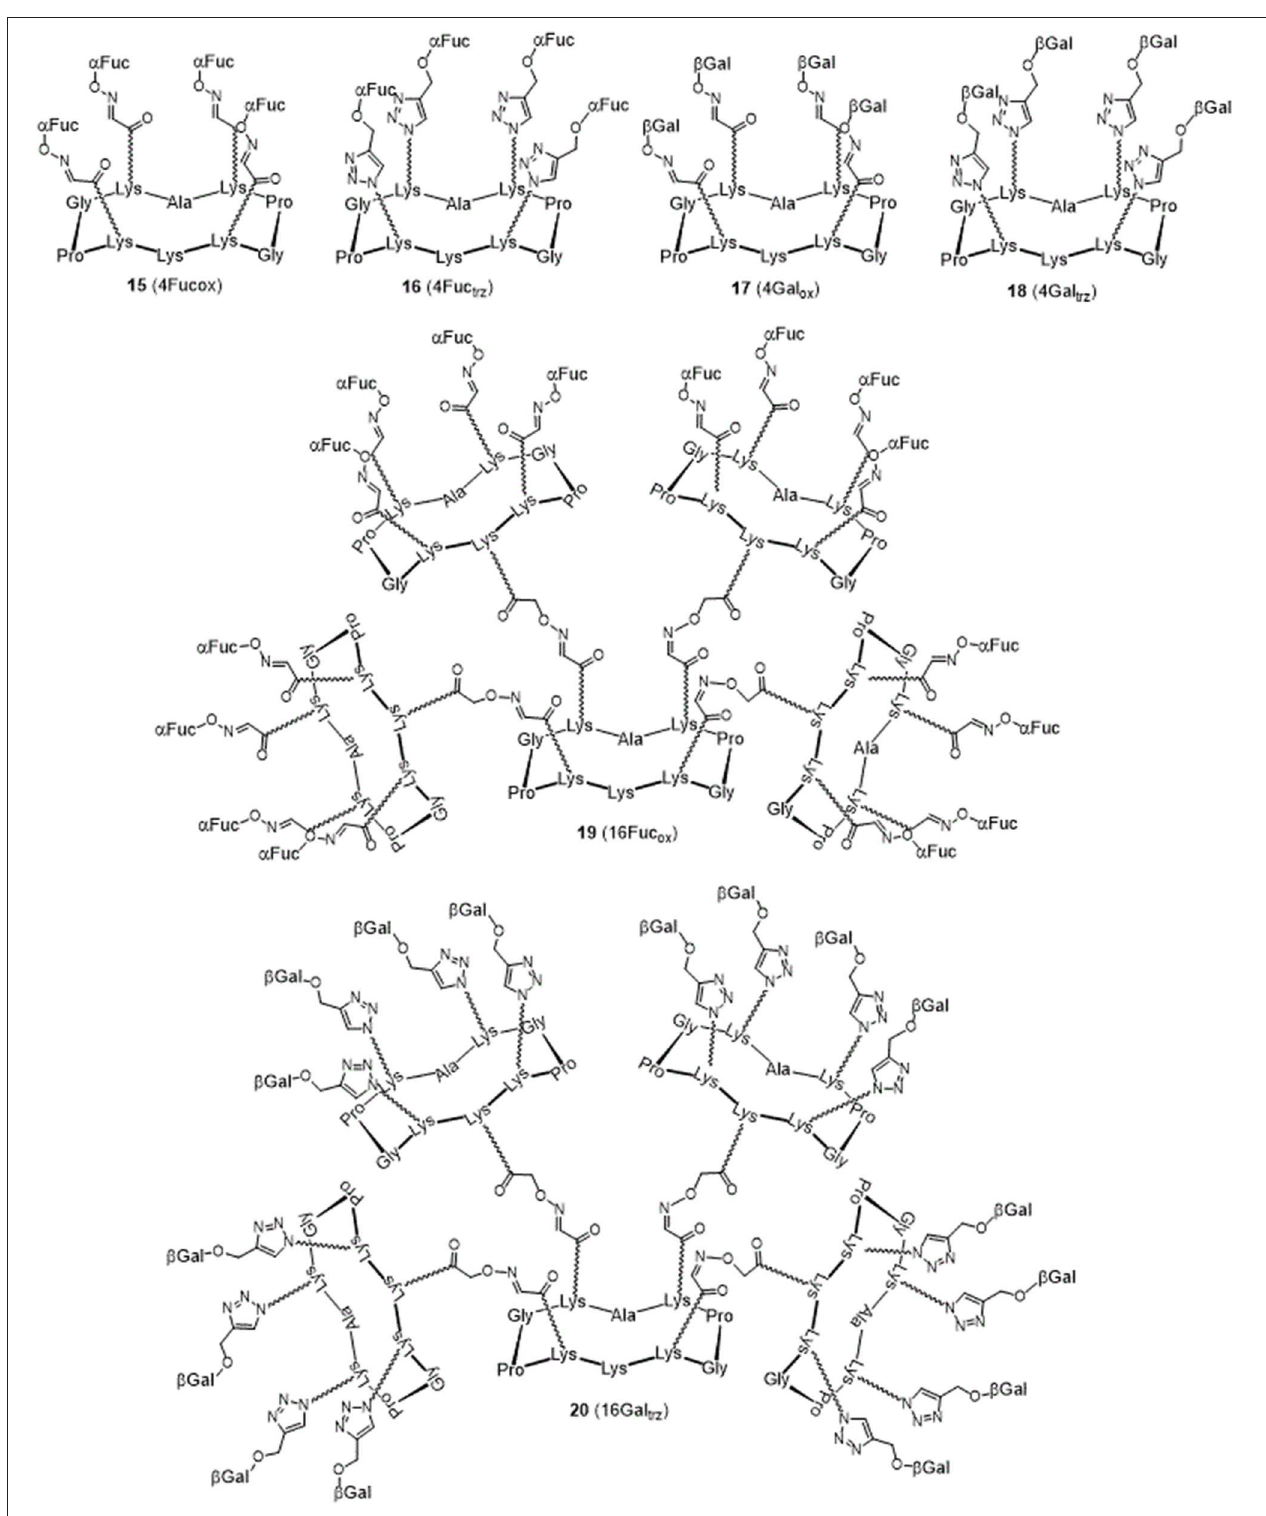
FIGURE 3 | Structure of the tetravalent ( 15–18 ) and hexadecavalent ( 19–20 ) homoclusters.